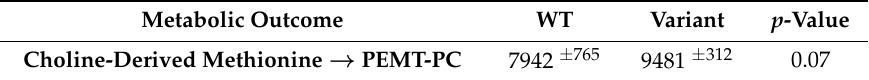
Table 12. PEMT rs7946 genotype alters the metabolic flux of choline-derived methionine → PEMT-PC in plasma. Values are least-squared means ± standard errors for each group in µ M PC/study period. Metabolic Outcome WT Variant p -Value Choline-Derived Methionine → PEMT-PC 7942 ± 765 9481 ± 312 0.07